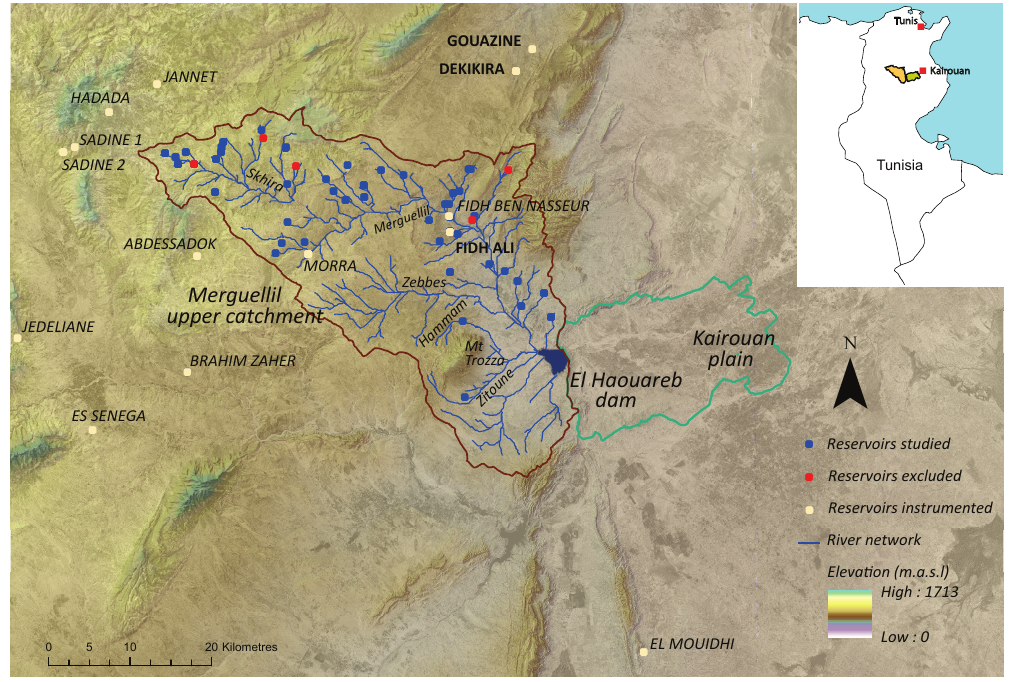
Figure 2. Location of Merguellil upper catchment and its small reservoirs and those with the stage data and surface-volume relationships employed